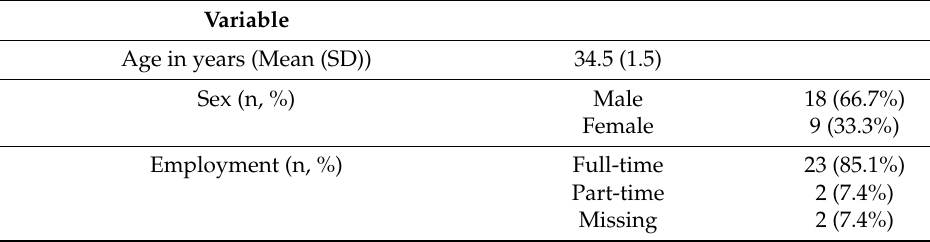
Table 2. Subjects’